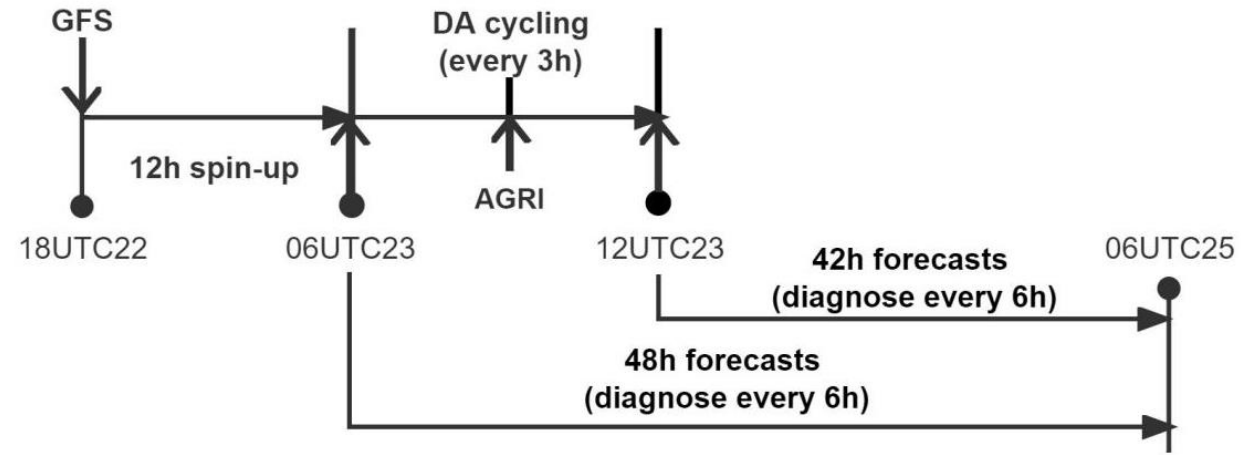
Figure 3. The flow charts of all the experiments listed in Table 2.